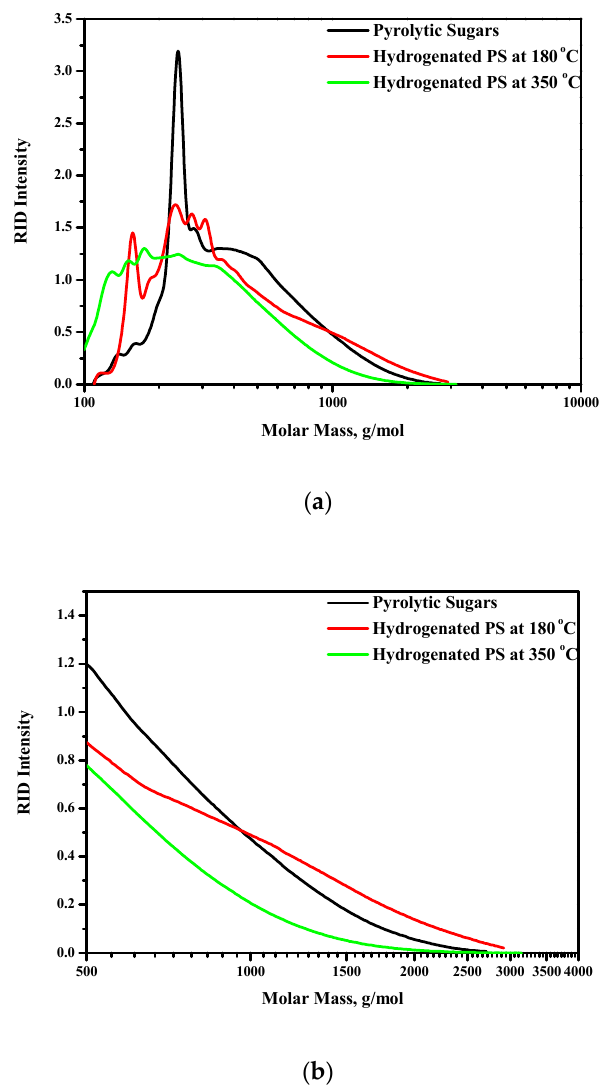
Figure A1. Molecular weight distribution for PS and the organic product oils from PS hydrotreatment obtained at 180 °C and 350 °C using ( a ) the Ni-Mo catalyst and ( b ) enlargement of the higher molecular weight tail.